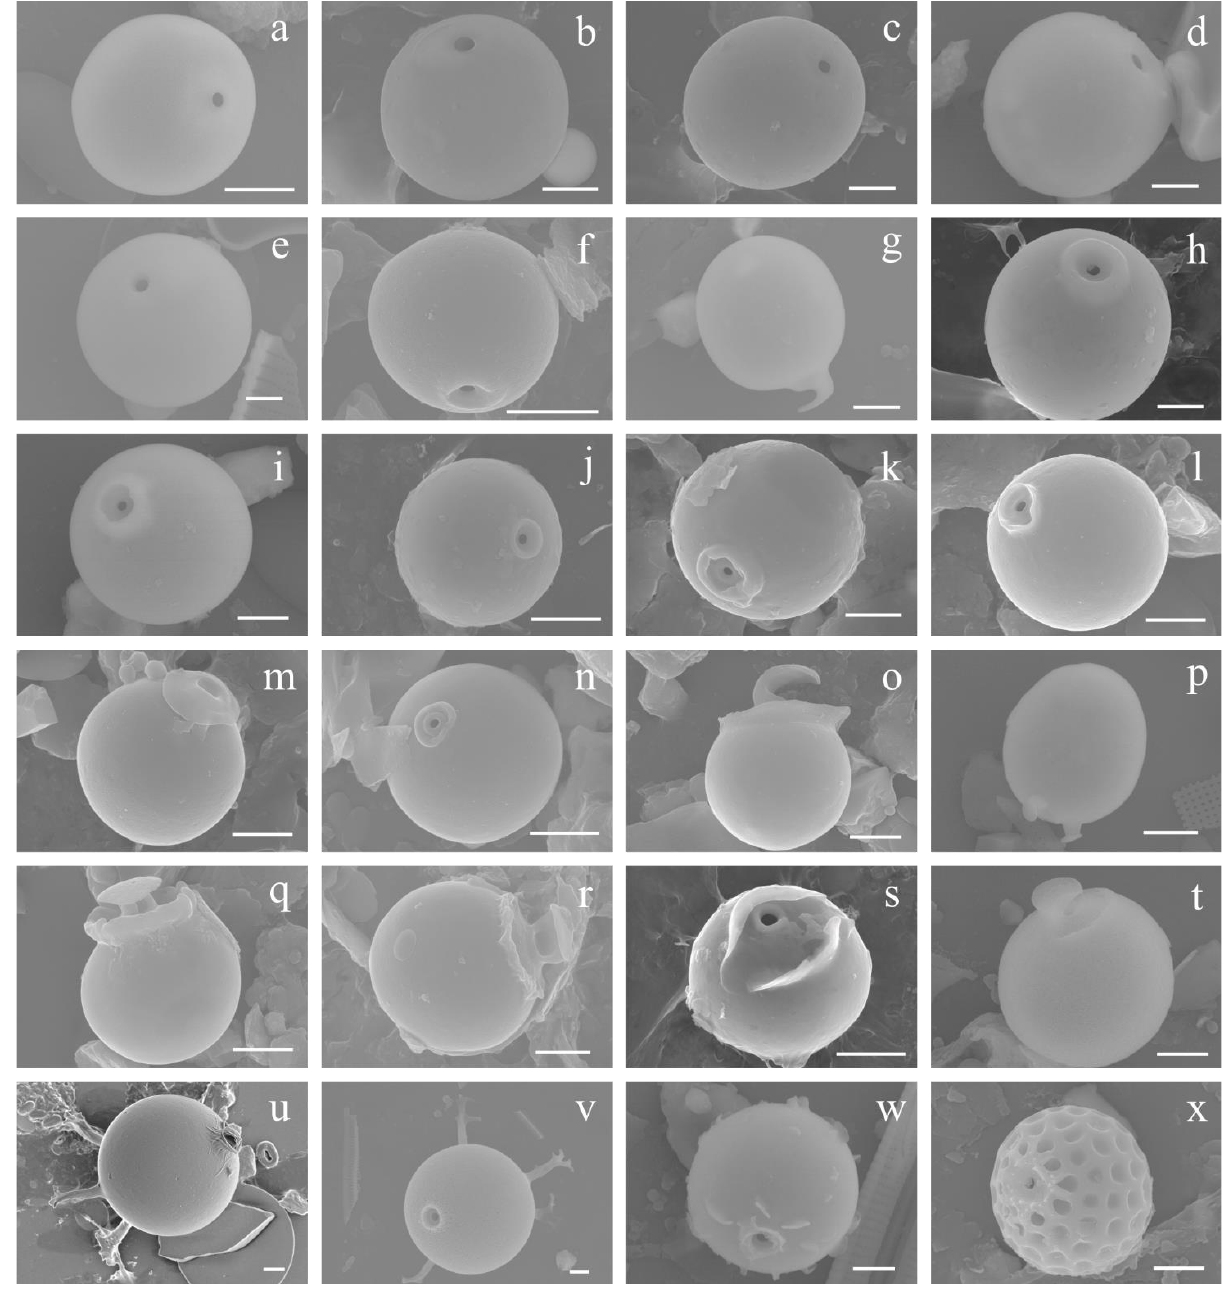
Figure 2. SEM pictures of chrysophyte stomatocysts. a: Stomatocyst 1, Duff & Smol 1988 emend . Zeeb & Smol 1993a; b: Stomatocyst 9, Duff & Smol 1988 emend . Zeeb & Smol 1993a; c: Stomatocyst 19, Duff & Smol 1988; d: Stomatocyst 120, Duff & Smol in Duff et al . 1992 emend . Zeeb & Smol 1993a; e: Stomatocyst 42, Duff & Smol 1989; f: Stomatocyst 110, Zeeb et al . 1990; g: Stomatocyst 134, Duff & Smol in Duff et al . 1992; h: Stomatocyst 181, Brown & Smol in Brown et al . 1994; i: Stomatocyst #1, Bai & Chen (this article); j: Stomatocyst 52, Duff & Smol 1991 emend . Duff et al . 1995; k: Stomatocyst 183, Brown & Smol in Brown et al . 1994; l: Stomatocyst 234, Duff et al . 1995; m: Stomatocyst 41, Pang & Wang 2017; n: Stomatocyst 16, Duff & Smol 1988; o: Stomatocyst 135, Duff & Smol in Duff et al . 1992; p: Stomatocyst 136, Duff & Smol in Duff et al . 1992; q and r: Stomatocyst 187, Brown & Smol in Brown et al . 1994; s: Stomatocyst #2, Bai & Chen (this article); t: Stomatocyst #3, Bai & Chen (this article); u: Stomatocyst 80, Hansen 2001; v: Stomatocyst #4, Bai & Chen (this article); w: Stomatocyst 334, Wilkinson & Smol 1998; x: Stomatocyst 86, Duff & Smol in Duff et al . 1995. Scale bars = 2